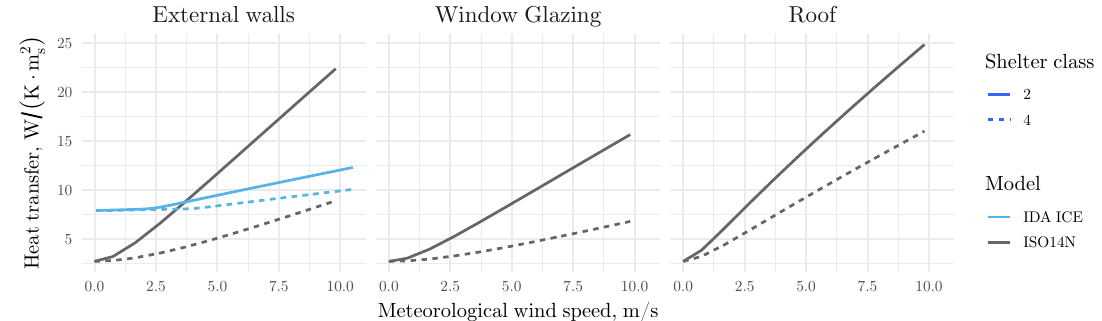
Figure 8. Exterior surface convective heat transfer coefficients calculated for two sheltering